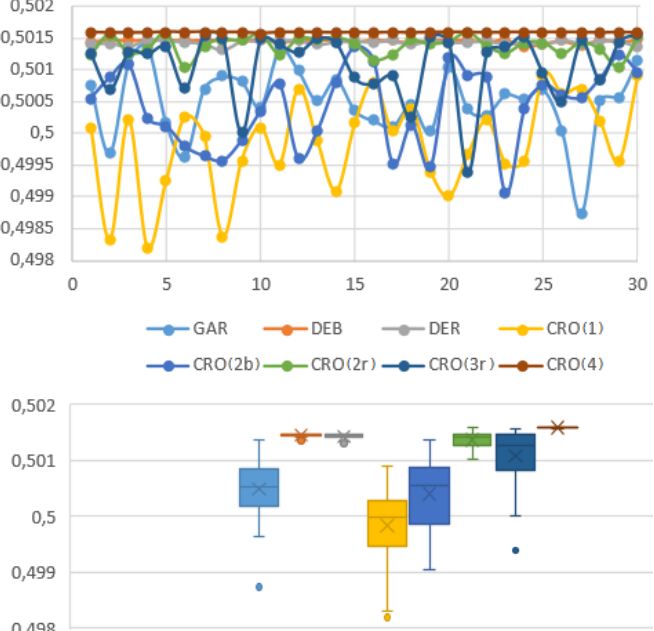
Figure 20. Scatter and Boxplot chart for the CRO with a single layer approach. Results obtained after 30 runs of the algorithm.